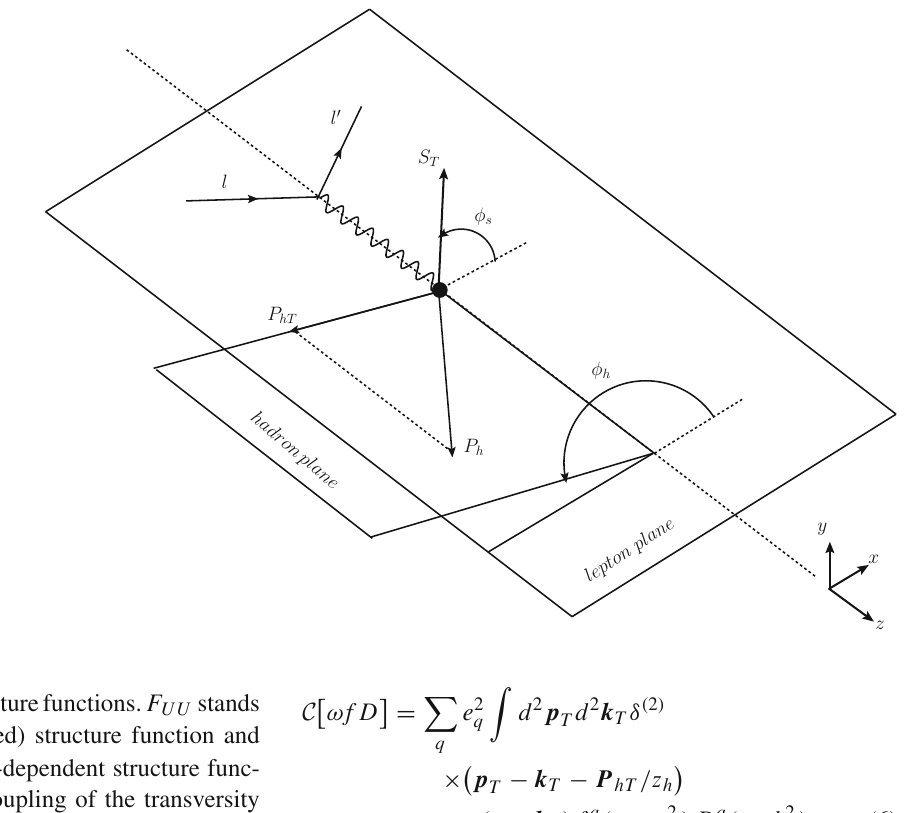
Fig. 1 The definition